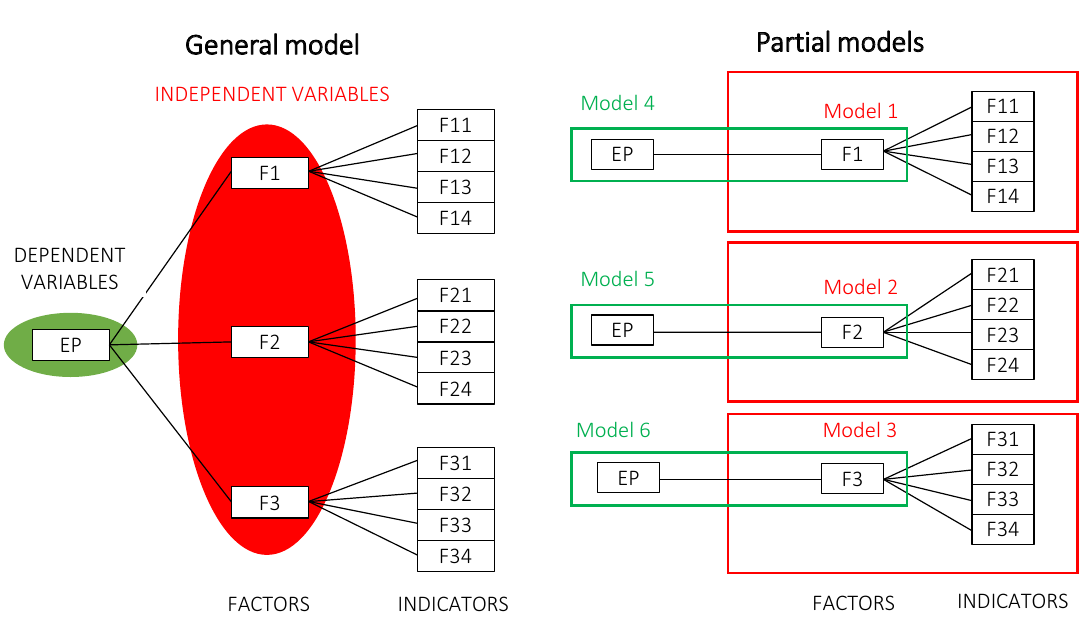
Figure 1. General predictive model and partial